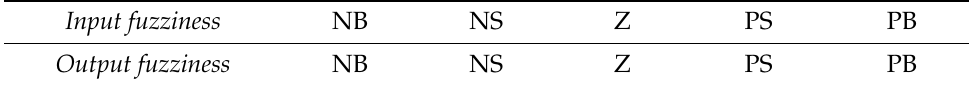
Figure 7. Fuzzy controller diagram. Table 2. Fuzzy